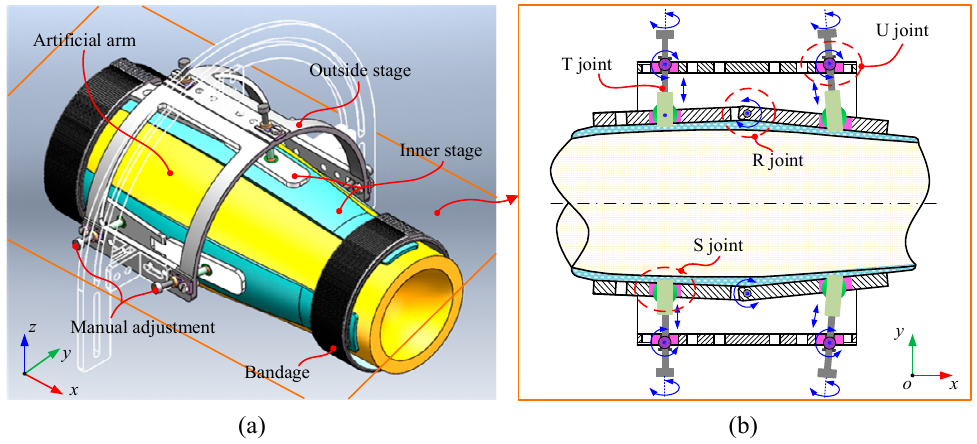
Figure 3. Design of the custom-designed cuff. ( a ) CAD model, and ( b ) projection drawing on the x-y plane.